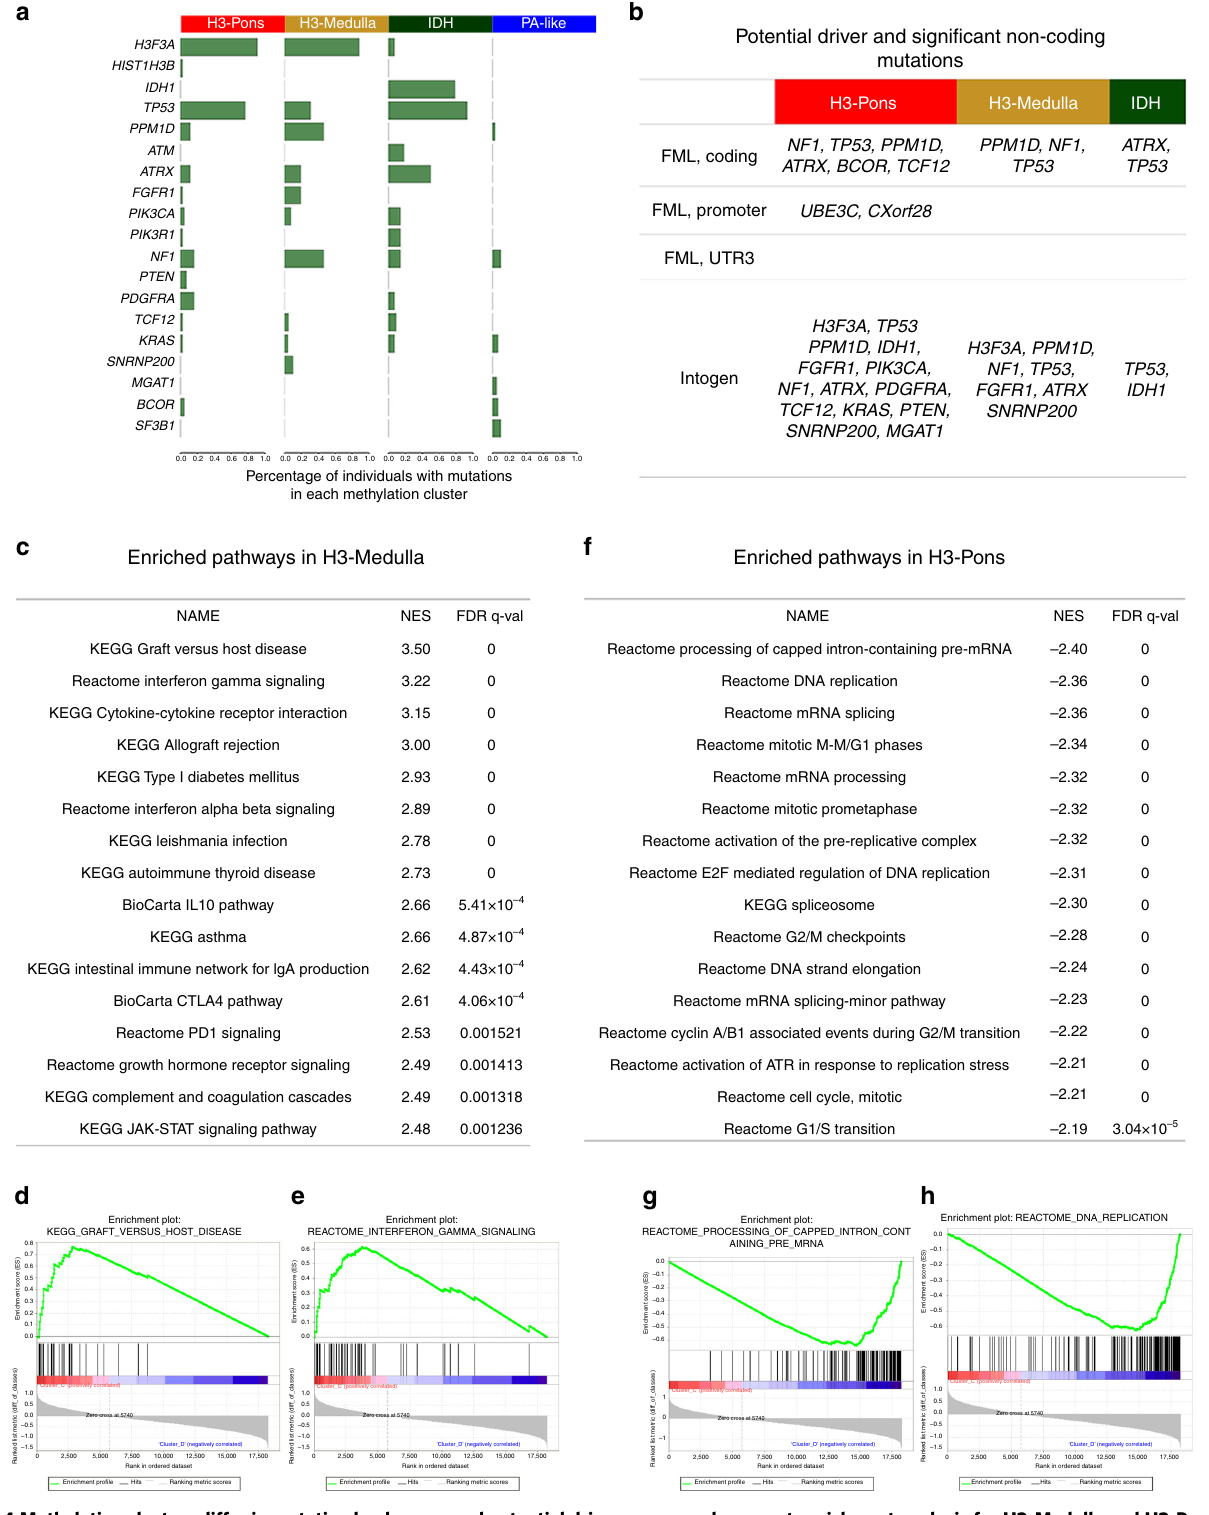
Fig. 4 Methylation clusters differ in mutation landscapes and potential driver genes, and gene set enrichment analysis for H3-Medulla and H3-Pons. a Frequency of mutations in each gene, grouped by clusters. b Potential driver and signi fi cant noncoding mutations for each cluster. c Enriched pathways in H3-Medulla ( d ) Enrichment Plot from H3-Medulla: KEGG Graft versus host disease ( e ) Enrichment plot from H3-Medulla Reactome Interferon gamma signaling ( f ) Enriched pathways in H3-Pons ( g ) Enrichment plot from H3-Pons: Reactome Processing of capped intron-containing pre-mRNA ( h ) Enrichment plot from H3-Pons: Reactome DNA